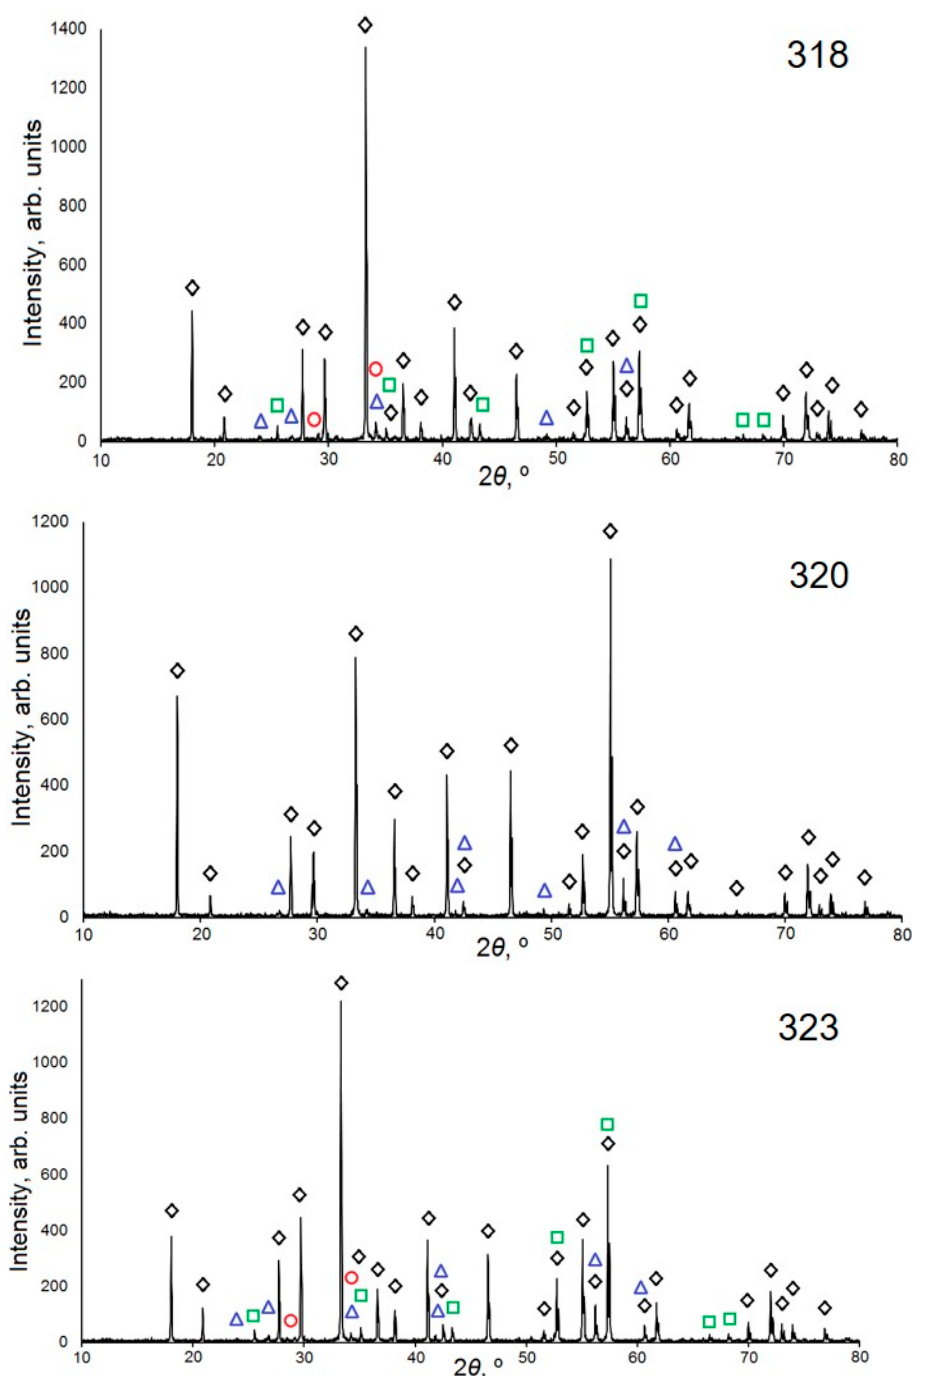
Figure 7. X-ray diffraction patterns of Y 3 Al 5 O 12 ceramic samples. Figure 7. X-ray di ff raction pa tt erns of Y 3 Al 5 O 12 ceramic samples. Designations: black rhombus— Y 3 Al 5 O 12 re fl ections, blue triangle—YAlO 3 , red circle—Y 2 O 3 , green square—Al 2 O 3 , black star— star—Y 4 A l2 O 9 . The serial number in the figures is the sample number in the accounting system Y 4 A l2 O 9 . The serial number in the fi gures is the sample number in the accounting system used by the authors.